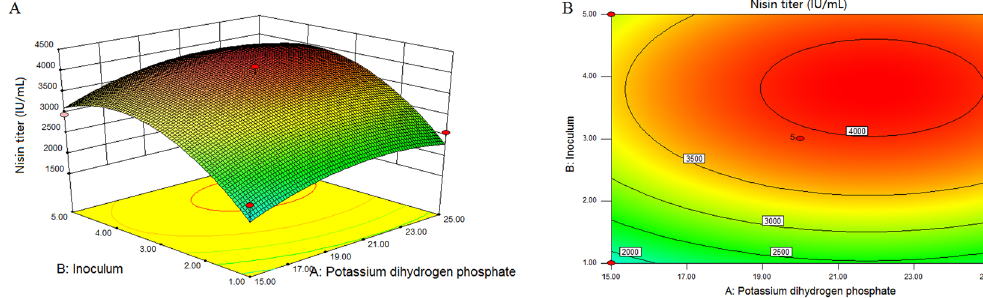
Figure 2. ( A ) Response surface plot and ( B ) corresponding contour of the mutual effects of KH 2 PO 4 and inoculum amount on nisin titer (8 h anaerobic fermentation at 30 °C).